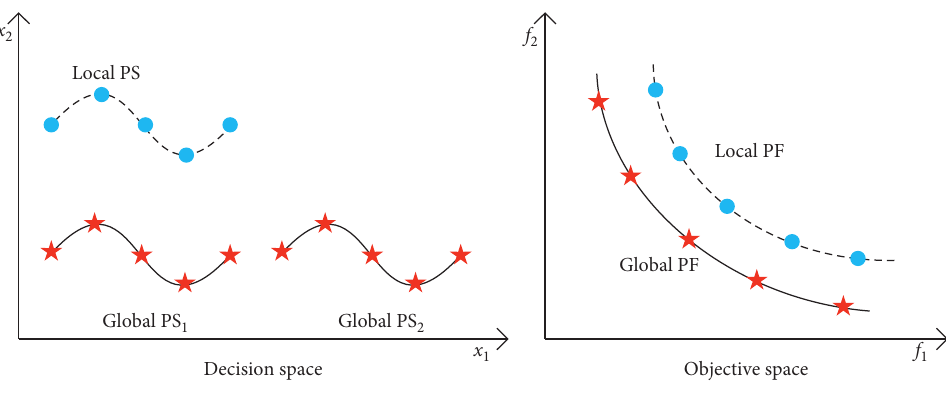
Figure 1: A case of